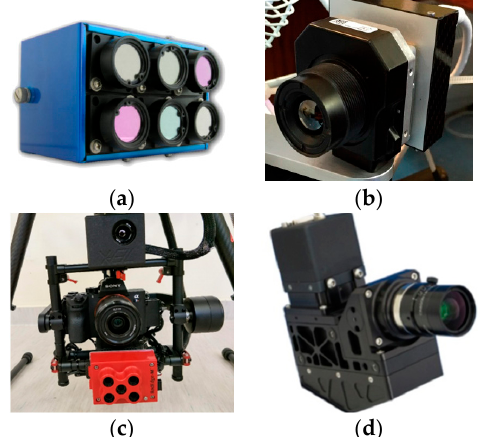
Figure 3. Some examples of sensors used on a UAS platform to study water status of horticultural crops: ( a ) A multispectral camera (Tetracam Mini-MCA-6, Tetracam, Inc., Chatsworth, CA, USA) [126]. ( b ) A thermal camera (FLIR TAU II, FLIR Systems, Inc., USA) [100,108]. ( c ) A multi-sensor camera setup with an RGB (Sony α 7R III, Sony Electronics, Inc., Minato, Tokyo, Japan), a multispectral (MicaSense RedEdge, MicaSense Inc., Seattle, WA, USA), and a thermal (FLIR TAU II 640, FLIR Systems, Inc., USA) camera. ( d ) A micro-hyperspectral camera (Micro-Hyperspec, Headwall Photonics, MA, USA)